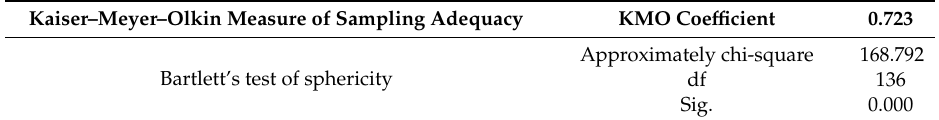
Table 2. Kaiser–Meyer–Olkin (KMO) and Bartlett’s